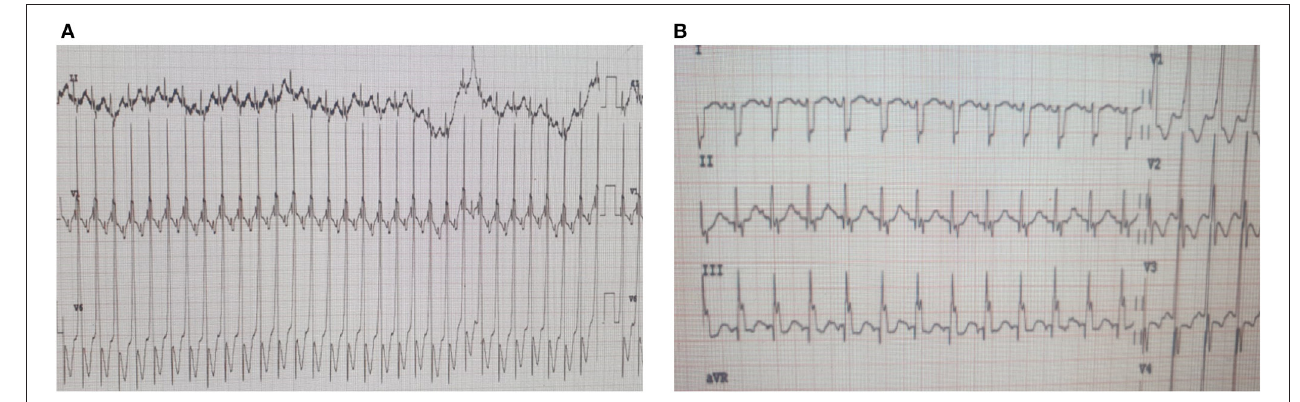
FIGURE 4 | ECGs of patient #2 pre- and post-ivabradine. (A) ECG revealing atrial tachycardia. (B) ECG revealing sinus rhythm (ECG speed: 25 mm/s, and sensitivity: 10 mm/mv). This patient was reverted adequately to sinus rhythm with combined amiodarone and